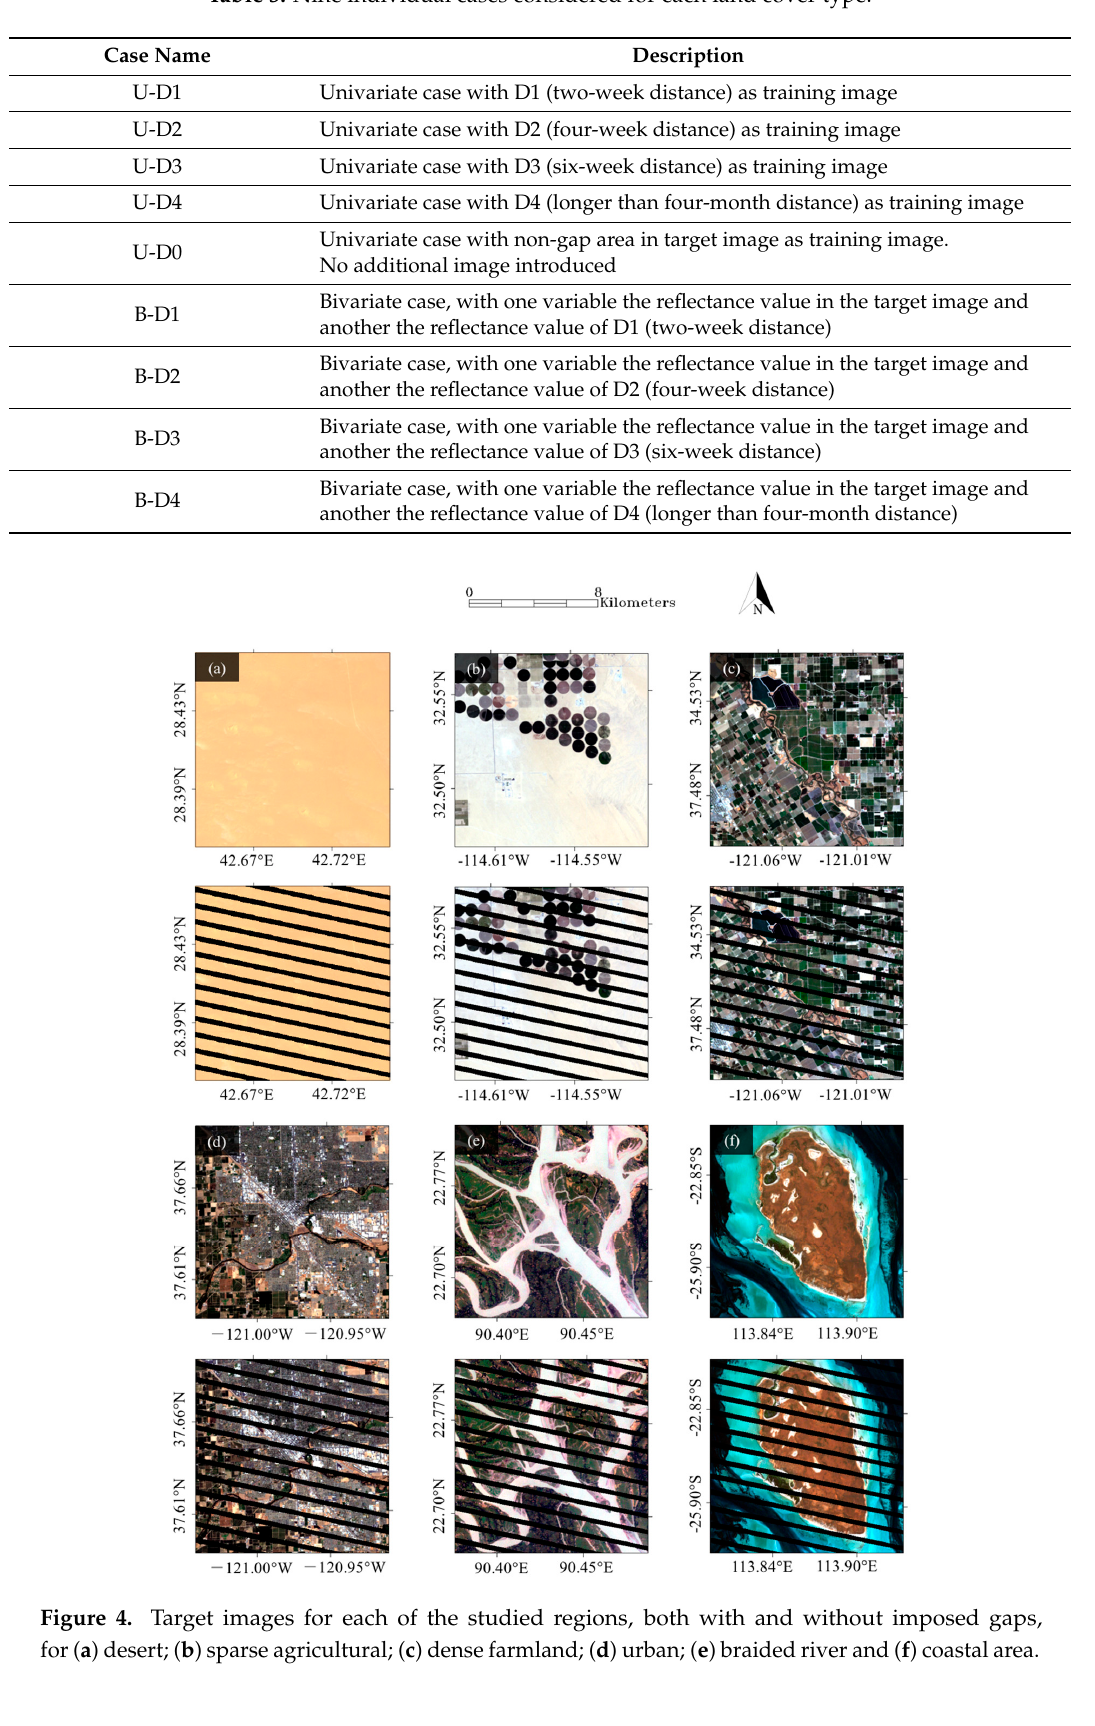
Table 3. Nine individual cases considered for each land cover type.